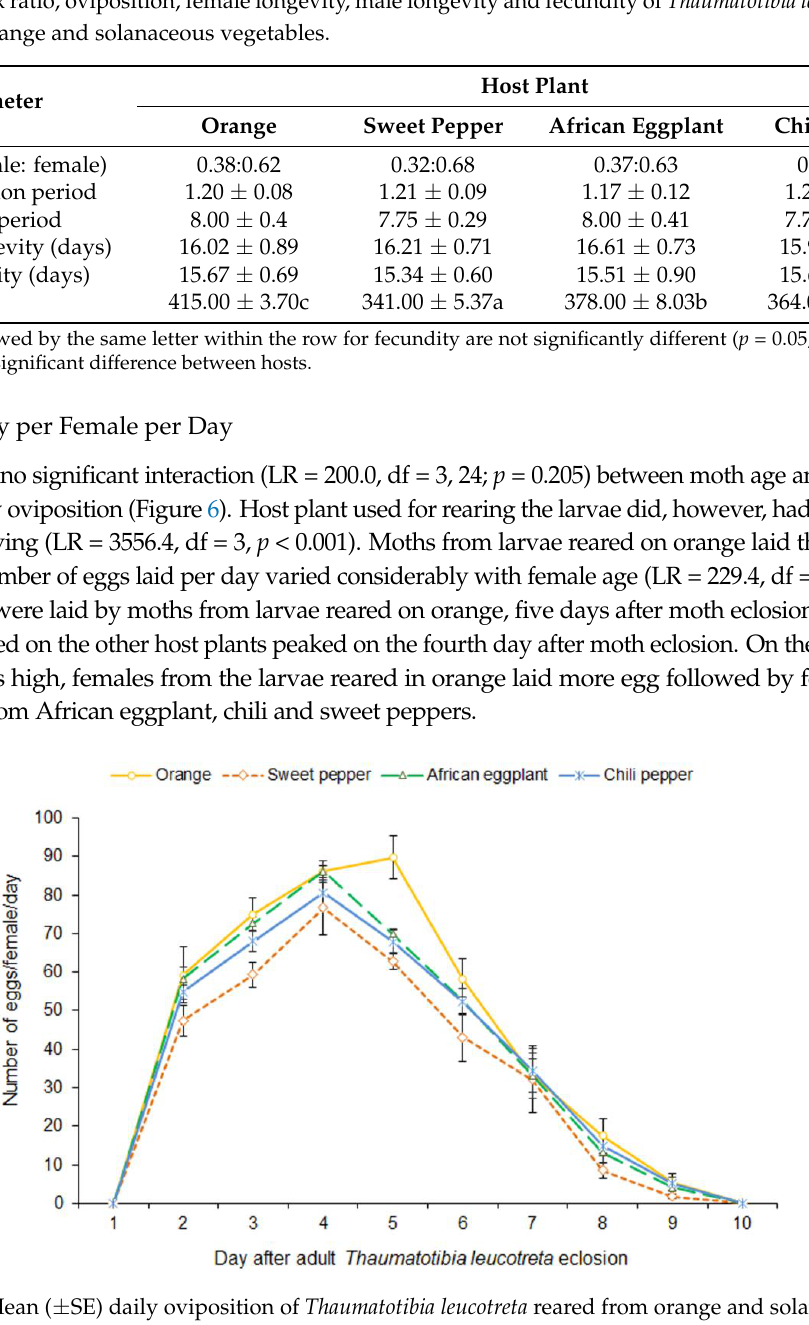
Figure 6. Mean ( ± SE) daily oviposition of Thaumatotibia leucotreta reared from orange and solanaceous host fruit.